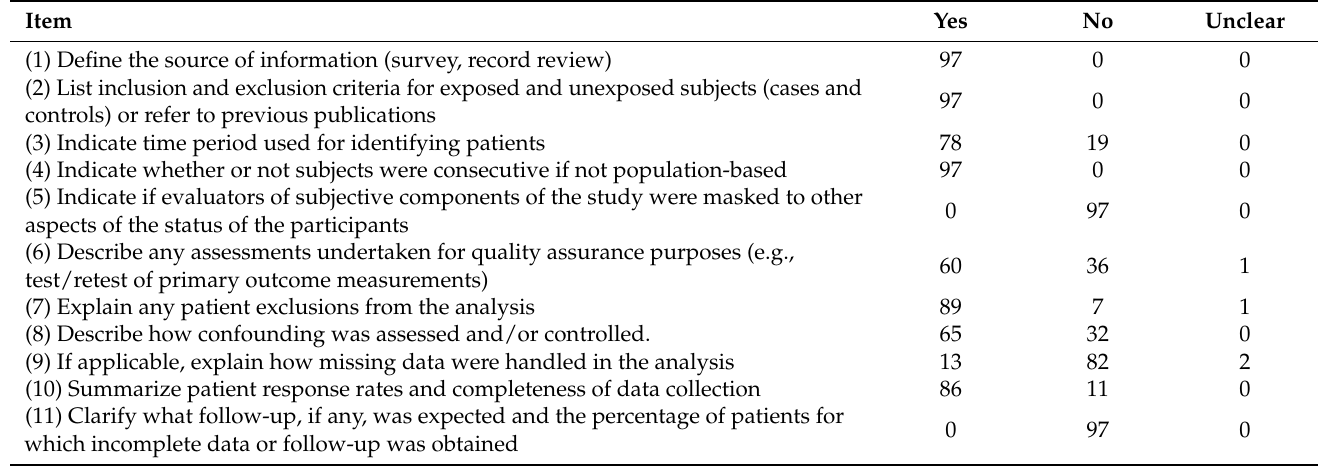
Figure 1. Flow chart of the study selection process. Table 1. Risk of bias using quality assessment